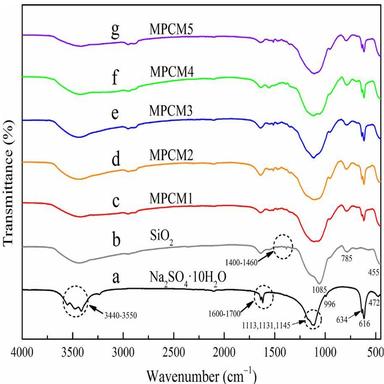
FT-IR spectra of (a) Na2SO4·10H2O, (b) silica, and (c–g) MPCM1–MPCM5.